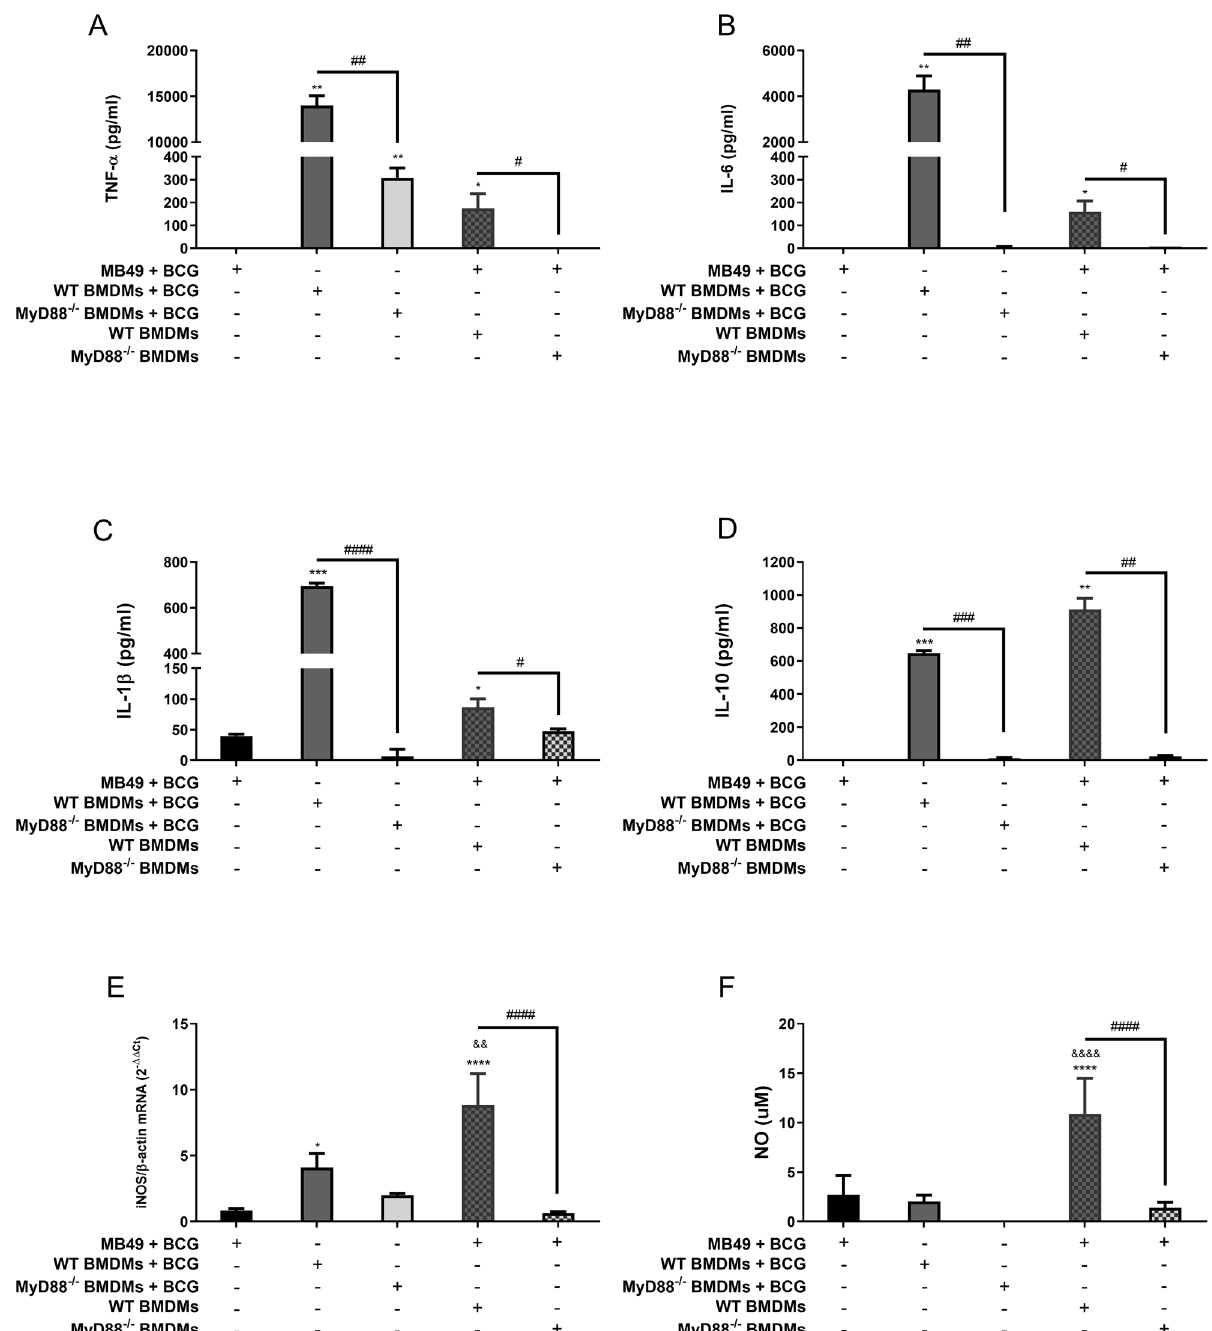
Figure 10. MB49 harboring BCG activates a MyD88-dependent inflammatory response in macrophages. MB49 cells used for co-culture were previously infected with BCG (MB49 + BCG) for 24 h and washed to remove free BCG in the supernatant, previously to the addition of C57BL/6 WT or MyD88 −/− macrophages in the co-culture. Co-cultured cells were maintained together for 24 h ( A – E ) or 48 h ( F ), when the samples were collected for analysis. MB49 or macrophages were also infected separated (not in co-culture) and used as controls. Measurement of TNF-α ( A ), IL-6 ( B ), IL-1β ( C ) and IL-10 ( D ) production in the supernatants after 24 h were performed by ELISA. ( E ) iNOS mRNA expression in co-cultured cells after 24 h was evaluated by qPCR. All qPCR results were relative to β-actin mRNA as a normalizer and C57BL/6 WT BMDM (mock) used as control. ( F ) NO production was evaluated by the Griess method in supernatants after 48 h of stimulation. Mock treated data are not shown in graphs. The values are representative of at least three independent experiments. *Statistically significant compared to MB49 + BCG, * P ≤ 0.05, ** P ≤ 0.01, *** P ≤ 0.001, **** P ≤ 0.0001. # Statistically significant data comparing C57BL/6 WT and MyD88 −/− BMDMs, # P ≤ 0.05, ## P ≤ 0.01, ### P ≤ 0.001, #### P ≤ 0.0001. & Statistically significant data comparing C57BL/6 WT BMDM in co-culture or not, && P < 0.01, &&&& P ≤